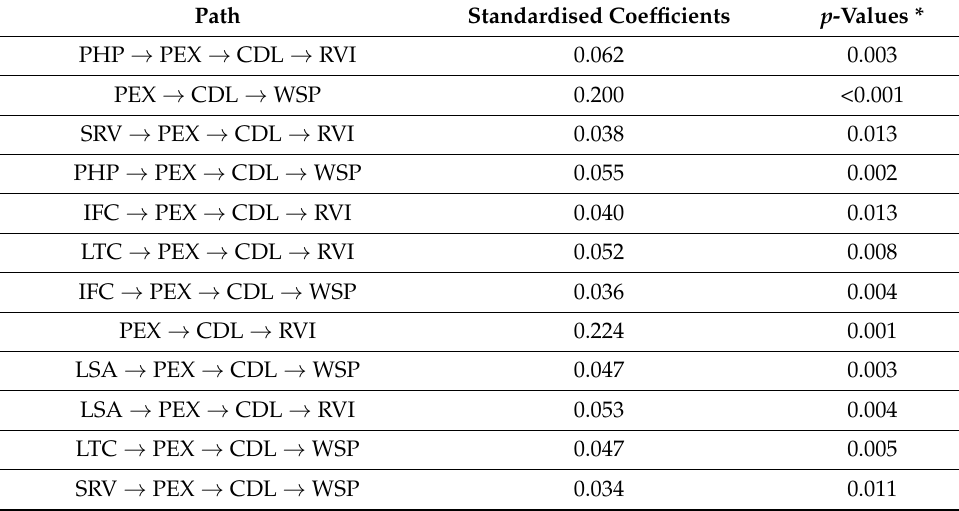
Table 8. Specific indirect effect.